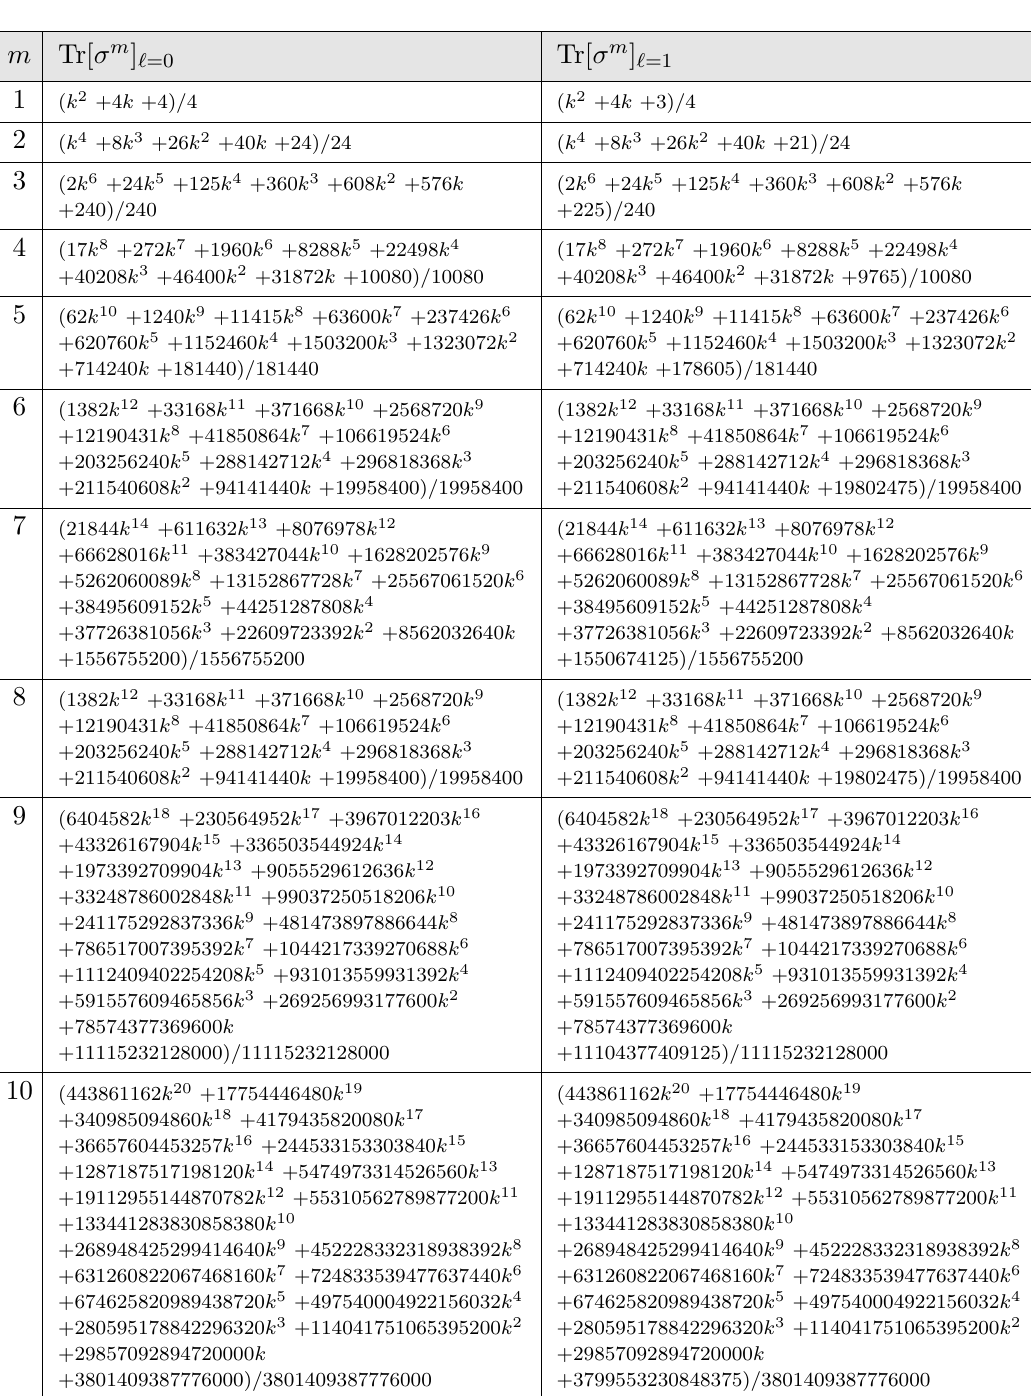
Table 3. The values of Tr [ σ m ] as a function of k for T 2 , 4 torus link. The subscript ‘ indicates that the polynomial is valid for k ≡ ‘ ( mod 2)